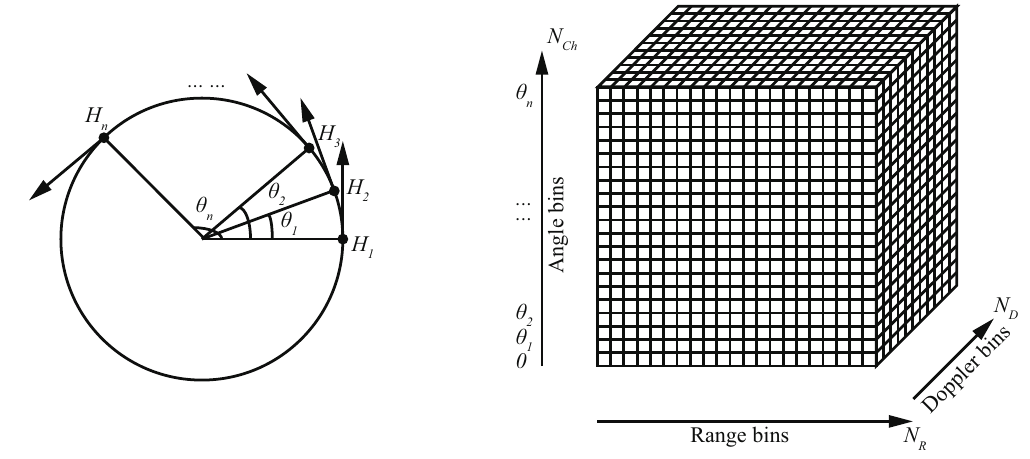
Figure 4. From projections to radar signal